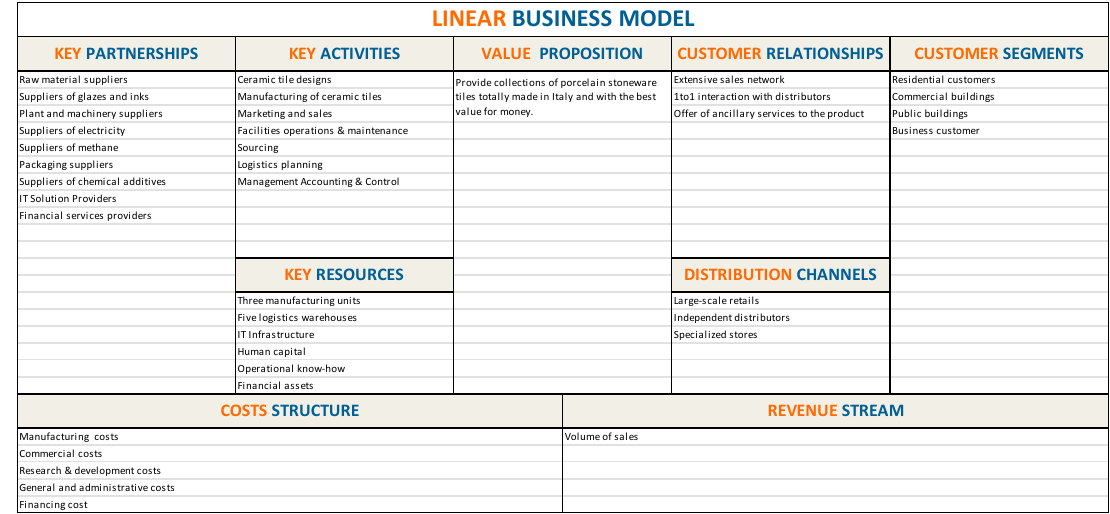
Figure 8. Representation of the current linear Business Model inspired by Business Model Canvas.